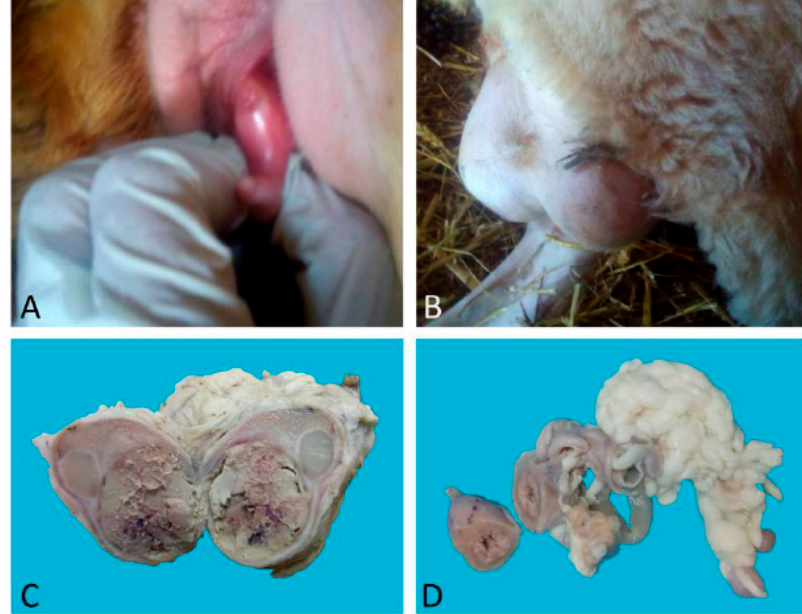
Figure 1. Case 1. ( A ) Posterior view in which a protruding penis-like clitoris is evident; ( B ) inguinal region in which two evident masses are visible; ( C ) and ( D ) transversal sections of one of the testes region in which two evident masses are visible; ( C , D ) transversal sections of one of the testes and of the and of the tubular structure found during necroscopy. tubular structure found during necroscopy.